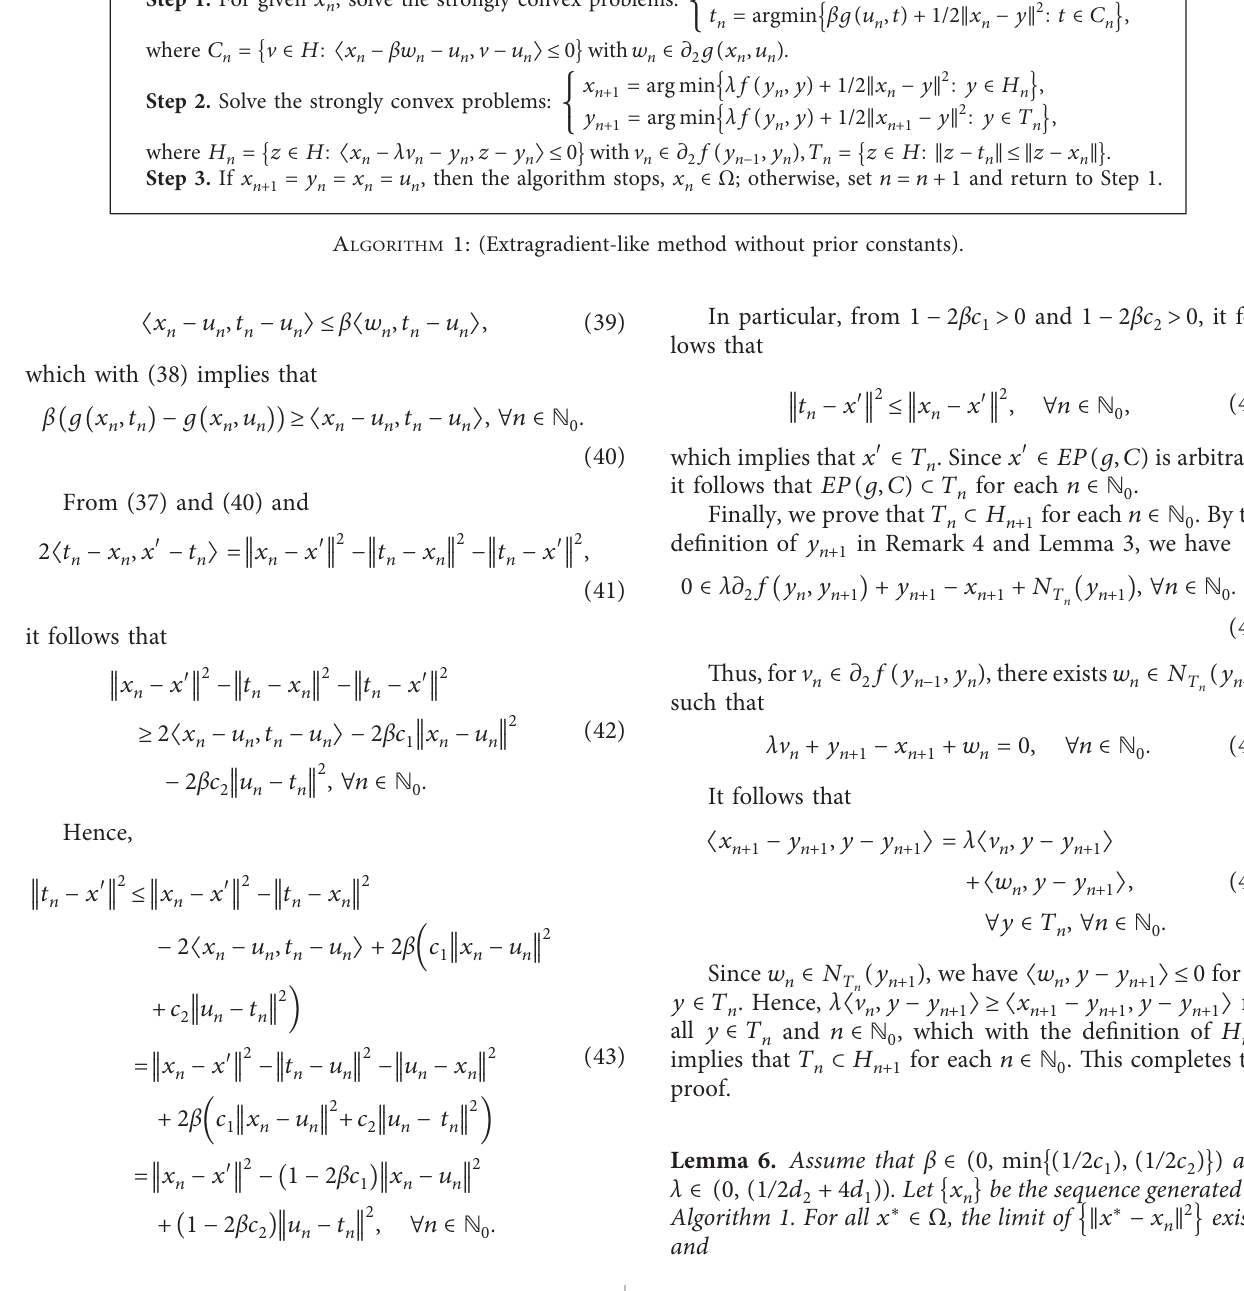
Algorithm 1. For all x ∗ ∈ Ω , the limit of ‖ x ∗ − x n ‖ 2